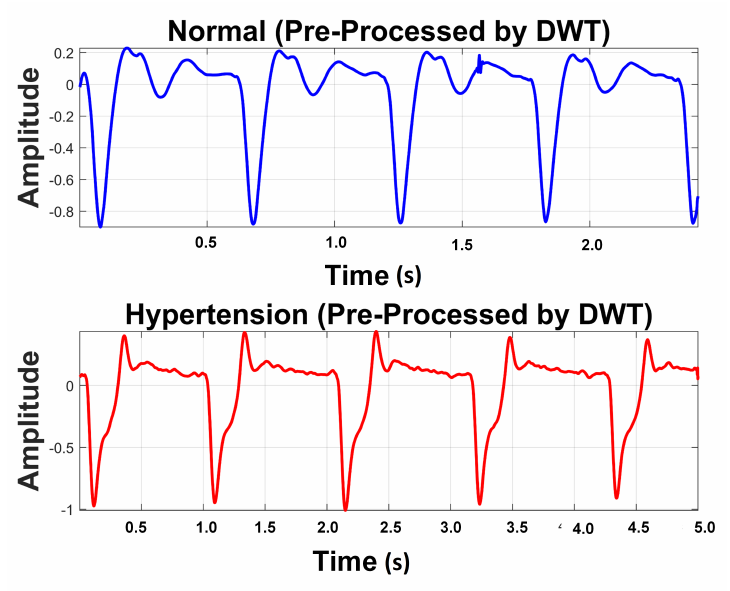
Figure 6. Denoised version of PuPG signal for Normal and Hypertension through